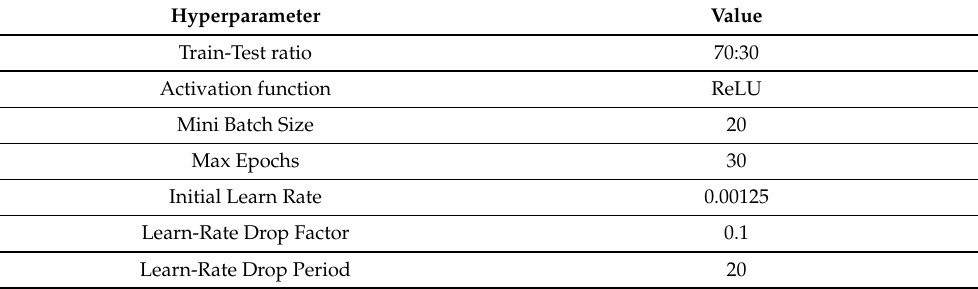
Table 8. Set of hyper-parameters for training baseline models using transfer